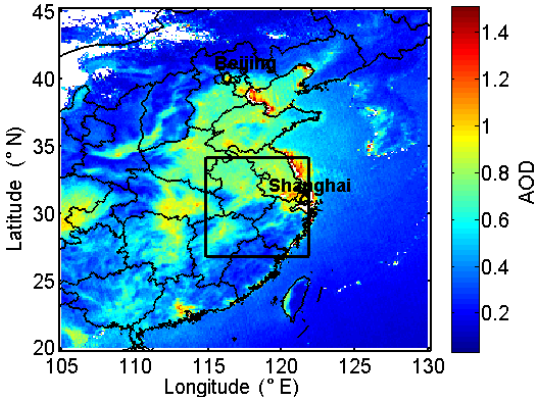
Figure 1. Map of annual averaged MODIS/AQUA level 2 AOD for all years during the period from 2007 to 2010. The black rectan- gle (27–34 ◦ N and 115–122 ◦ E) indicates the Yangtze River Delta